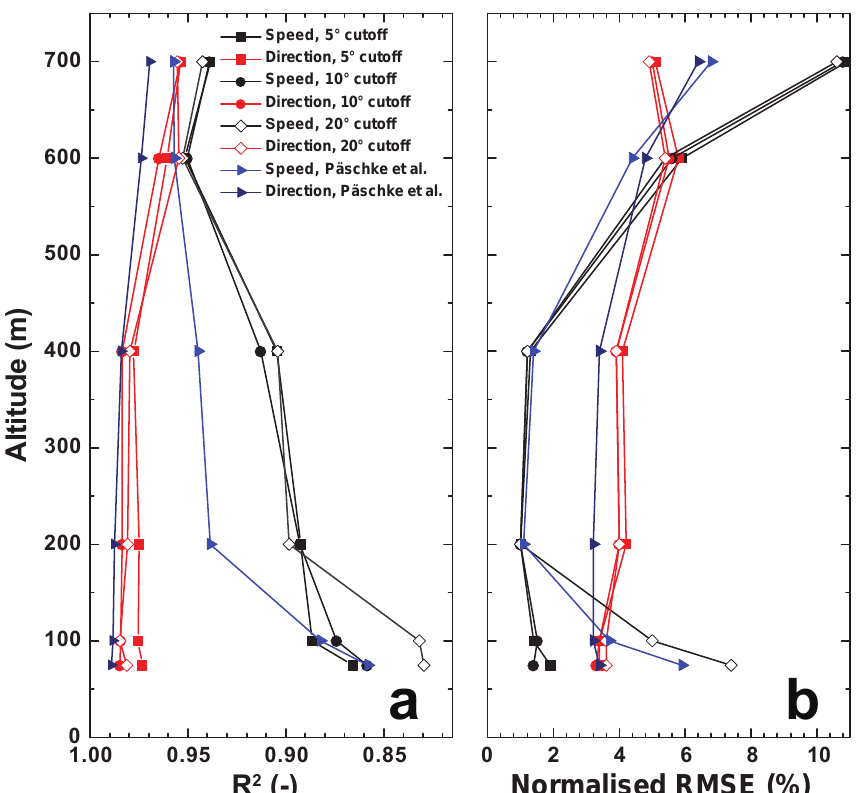
Figure 5. Squared correlation coefficient (a) and normalised RMSA (b) of derived wind speed (black) and wind direction (red) from lidar vs. radiosonde for different altitudes. Squares, circles and diamonds refer to cut-off angles of 5, 10 and 20 ◦ in the change of heading of the ship during one scan, respectively. The blue line refers to findings obtained using the quality assurance criteria of Päschke et al. (2015). Table 3. Statistics of the comparison between lidar and radio sounding at heights of 75, 100, 400, 600, and 700m.